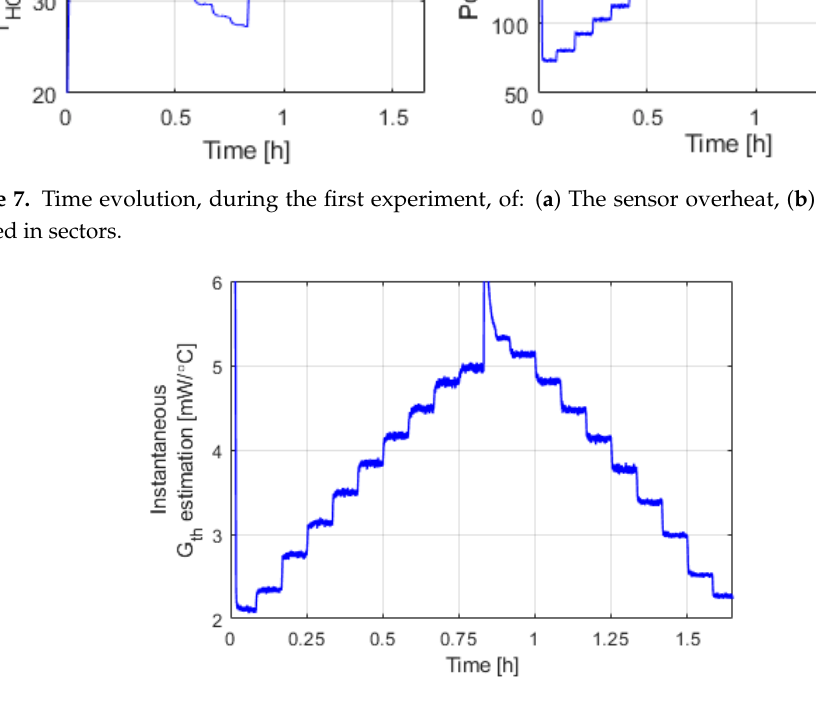
Figure 8. Time evolution of the estimated instantaneous total convective heat transfer coefficient of the sphere, G th , during the experiment of Figures 6 and 7.